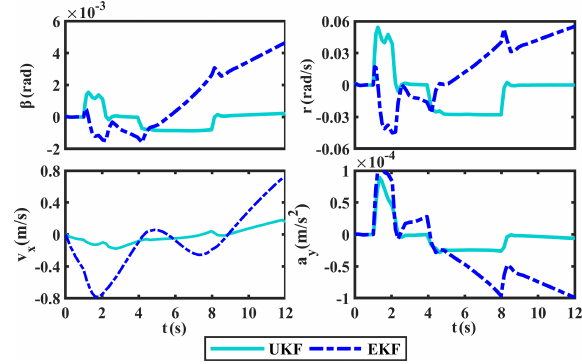
β , r , v x , and a y , along with their corresponding error curves, are displayed in Figs. 14, 15, and 16, respectively.